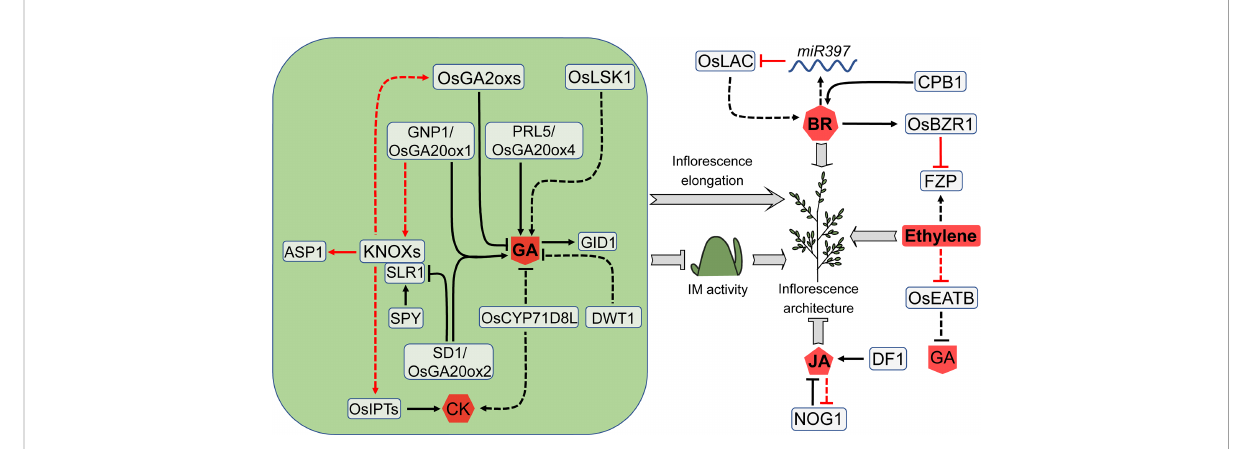
FIGURE 6 Factors involved in GA- and other hormone-mediated regulation of rice in fl orescence architecture. Through an opposite way, GA promotes branch elongation or inhibits meristem activity to in fl uence the rice in fl orescences architecture. GA antagonizes CK in maintaining meristem activity, and KNOX genes act as coordinators between GA and CK. Several additional hormones also have a substantial impact on rice in fl orescence architecture. These hormone regulators form a complicated network that in fl uences one another. Arrows and blocked arrows represent positive and negative regulation, respectively. Solid and dashed lines represent direct and indirect regulation, respectively. Red and black lines represent regulation between factors at transcriptional and protein level, respectively. BR, brassinosteroid; CK, cytokinin; GA, gibberellin; JA, jasmonic